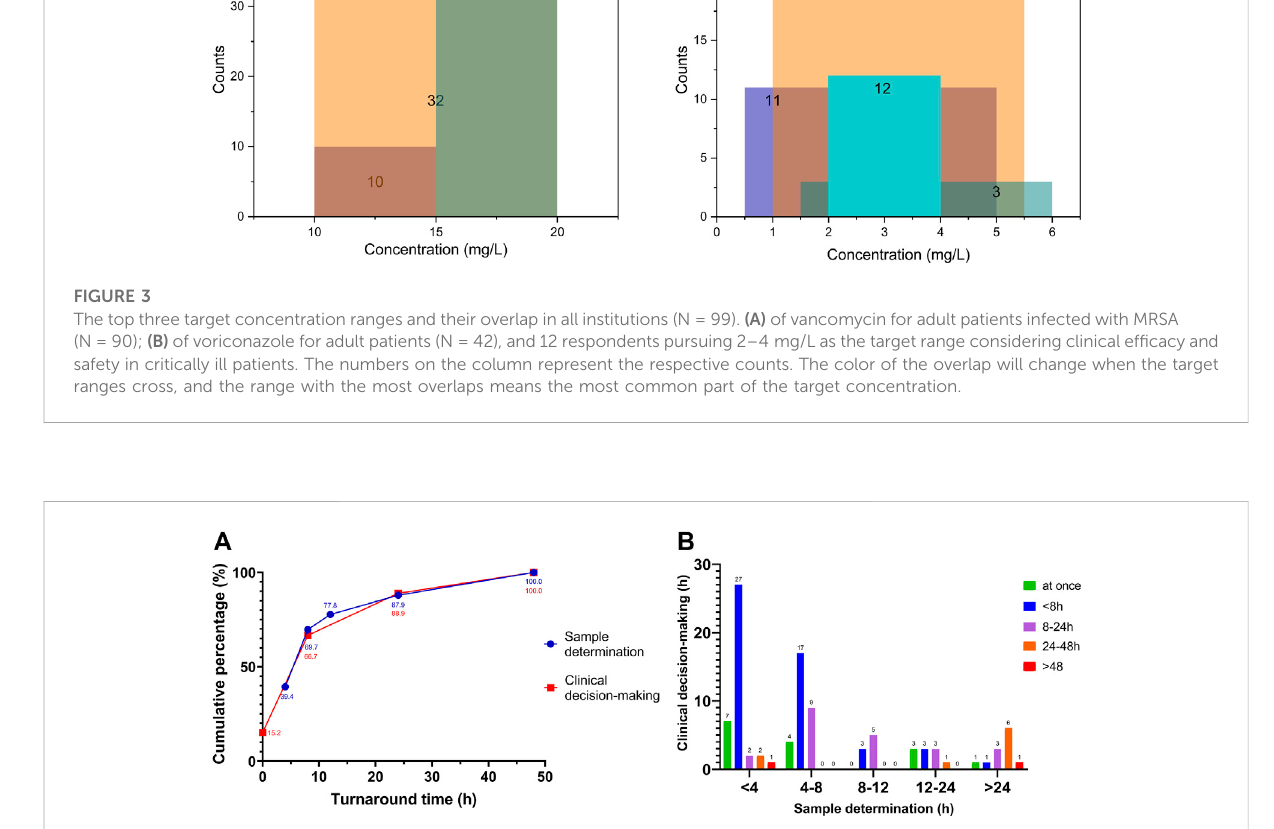
FIGURE 4 The ef fi cacy of TDM services in sample determination and clinical decision-making. (A) the cumulative percentage of these two processes completed over time (150 and 99 responses, respectively); (B) the distribution of the 99 responses. The sample determination means from sampling to TDM result; clinical decision-making means from TDM result to clinical